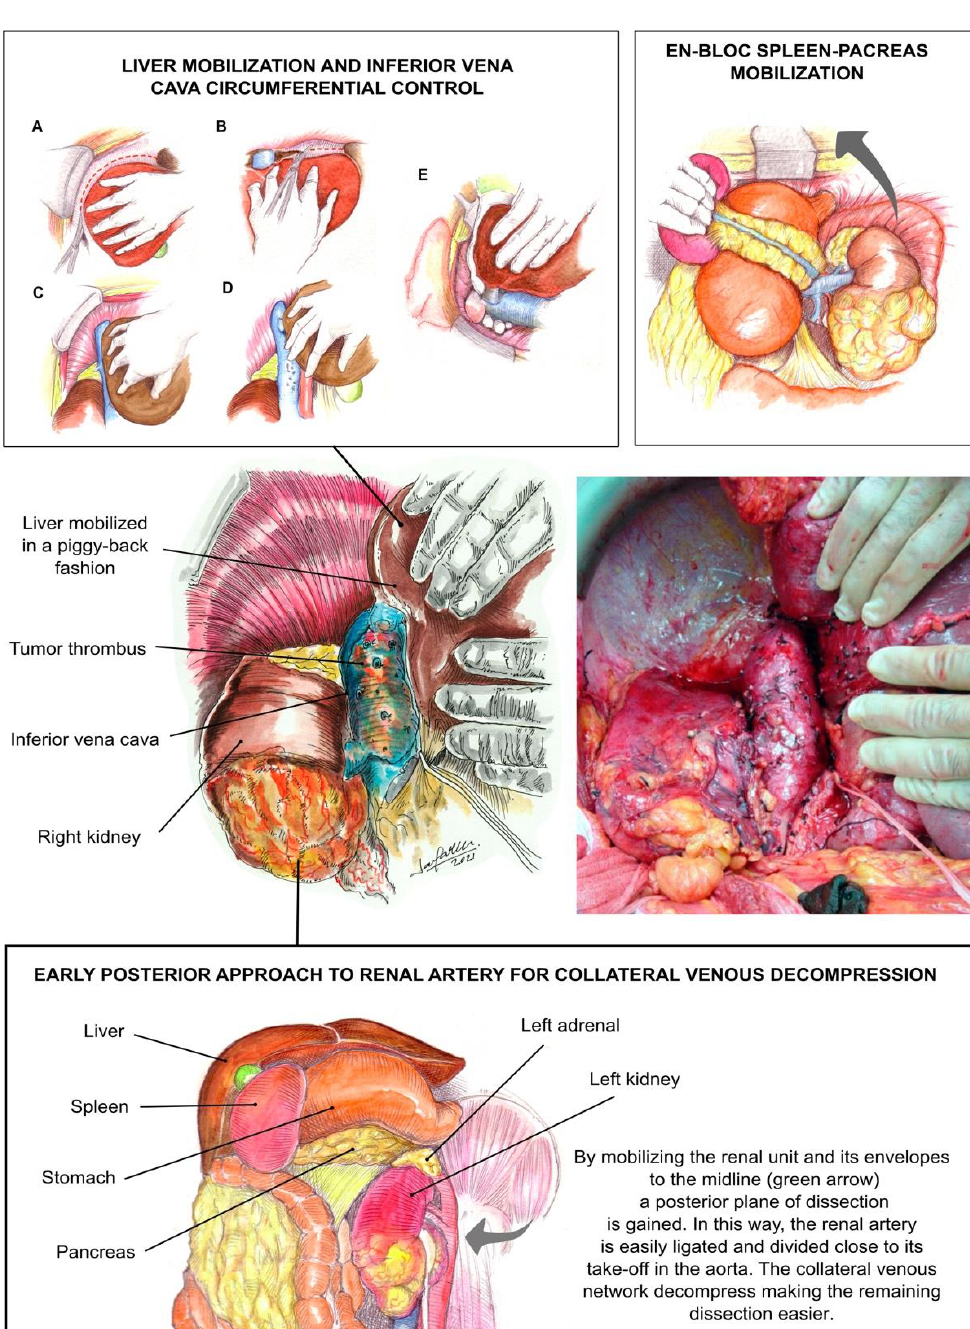
Figure 2. Transplant-based approach to radical nephroureterectomy in conjunction with tumor thrombectomy. Central figures show the complete exposure of the infrahepatic and retrohepatic segments of the inferior vena cava in the patient harboring a level IIIa tumor thrombus. The liver is mobilized commencing by dividing the left and right triangular ligaments ( A and B , respectively). Once the right coronary ligament is divided, the right hepatic lobe can be gradually rolled to the midline ( C ). Piggy-back liver dissection requires the control and division of all the short veins communicating the right and caudate lobes with the anterior aspect of the inferior vena cava ( D ). In addition, the inferior vena cava is controlled circumferentially by detaching its posterior aspect from the posterior body wall ( E ). Further dissection is facilitated by early ligation of the main renal artery of the kidney involved. Early ligation is accomplished by gaining a posterior plane of dissection and mobilizing the entire kidney to the midline. Ligation is performed close to the take-off of the renal artery in the aorta. By ligating the renal artery, the collateral venous network generated in response to caval occlusion decompress, thus making the dissection less prone to